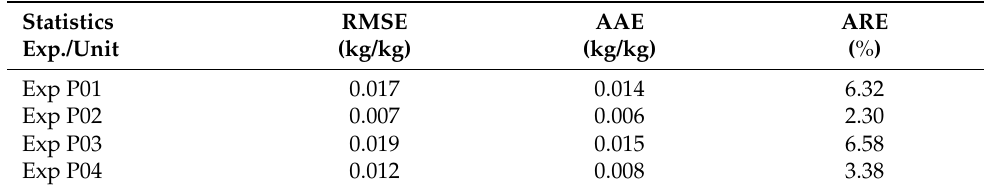
Table 3. The calculated measures of the statistics for a comparison of the experimental concentration measurements and the model